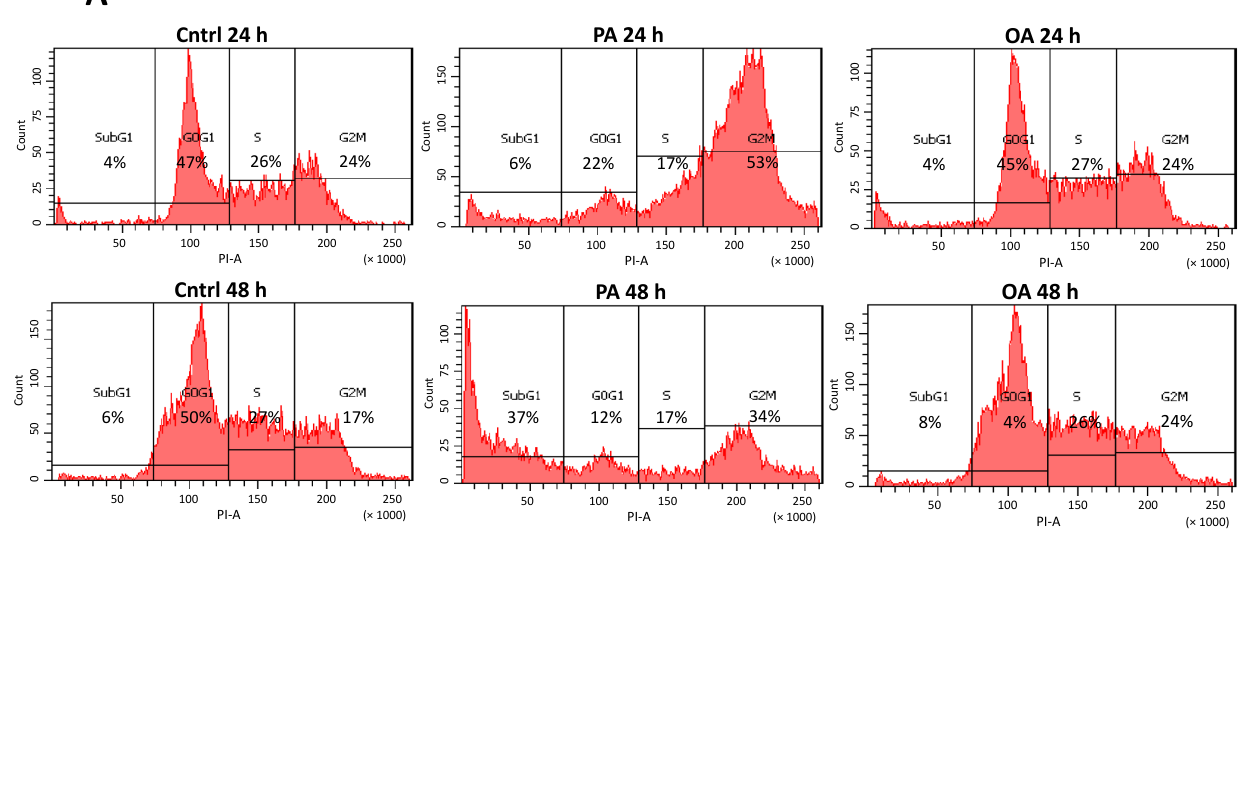
Figure 4. Effects of palmitic acid (PA) and oleic acid (OA) on the SH-SY5Y cell cycle. ( A ) Cells were treated with the vehicle control (Cntrl), 0.3 mM PA or 0.3 mM OA for 24 ( top ) and 48 h ( bottom ). The cell cycle was then analyzed by flow cytometry; ( B ) Quantified data are shown as the percentages of the four phases divided by the DNA content in the cell cycle. SH-SY5Y cells were treated with the vehicle control (Cntrl), 0.1 mM PA or 0.1 mM OA for 24 ( top ) and 48 h ( bottom ) and ( C ) Cells were treated with the vehicle control (Cntrl), 0.3 mM PA or 0.3 mM OA for 24 ( top ) and 48 h ( bottom